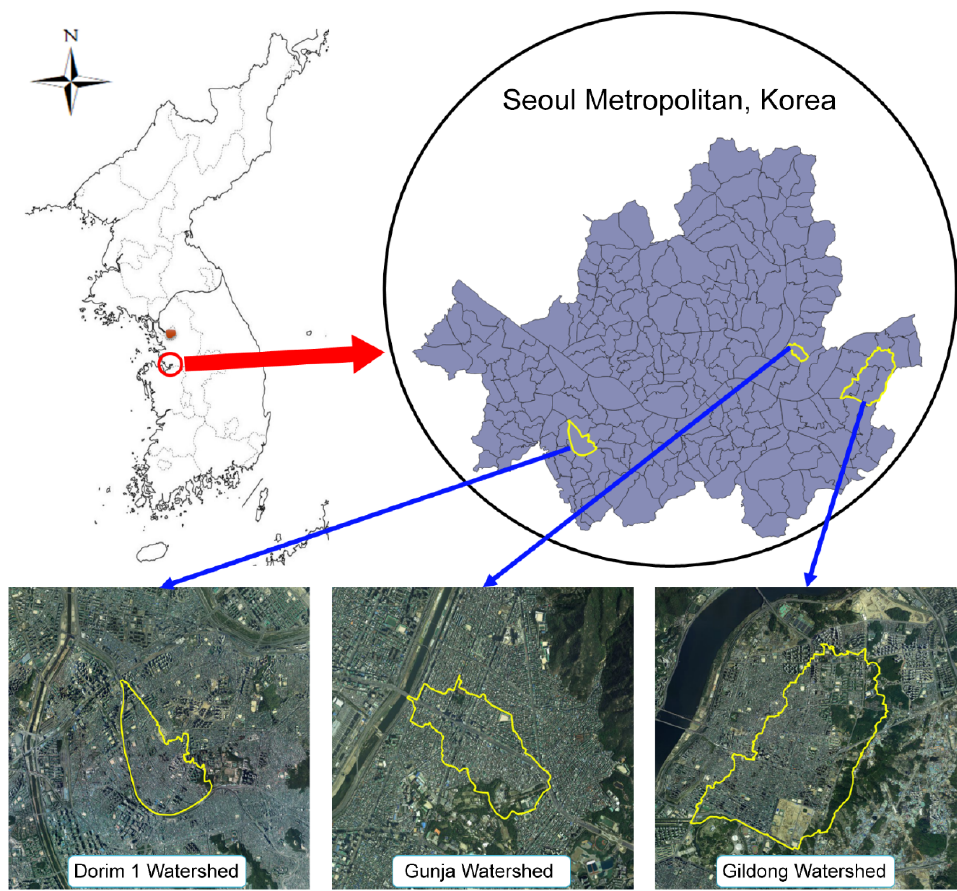
Figure 7. Target watersheds for inundation analysis.